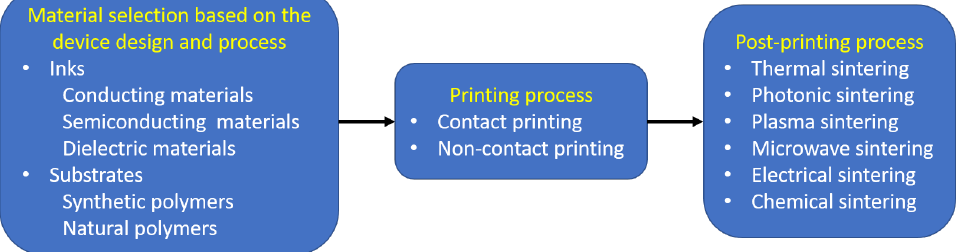
Figure 1. Complementary steps for electronics